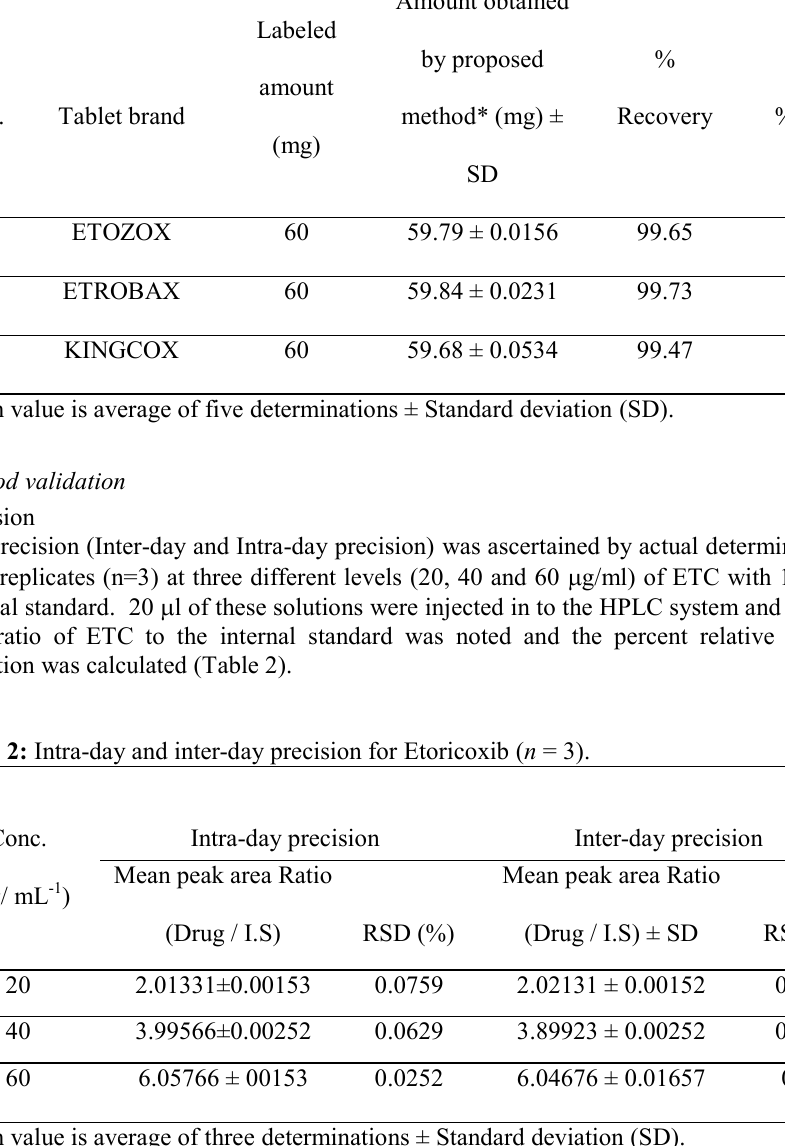
*Each value is average of three determinations ± Standard deviation